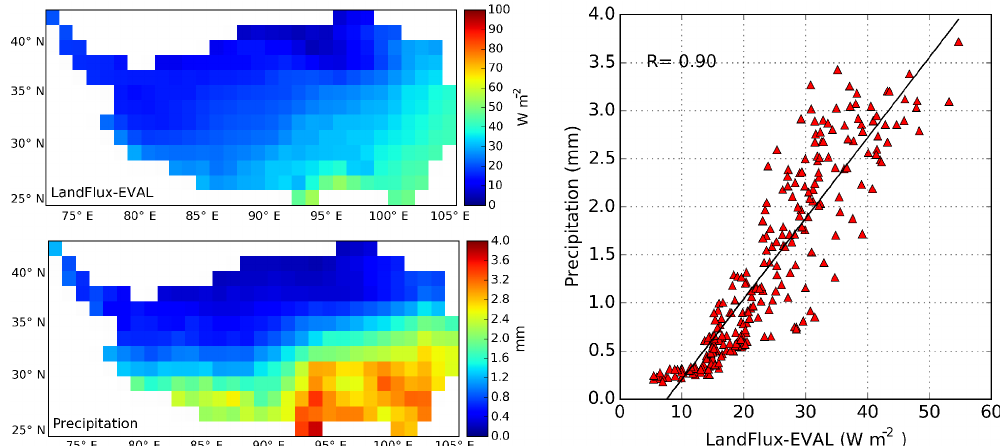
Figure 2. Spatial distribution of annual mean LandFlux-EVAL LE and GPCP precipitation over the TP (left panel). The scatter plots of the comparison between LE and precipitation for all the pixels (right panel).